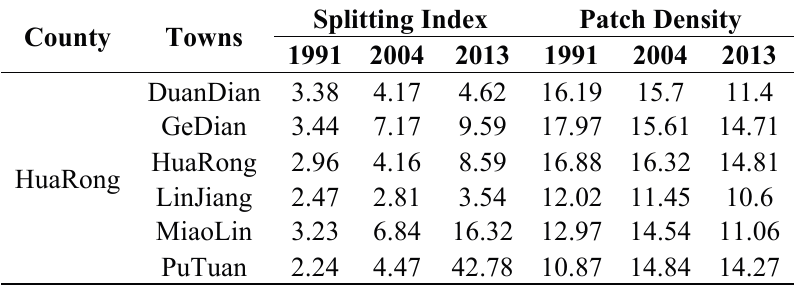
Table A2. Landscape Metrics at the Town Level in the Study Region over